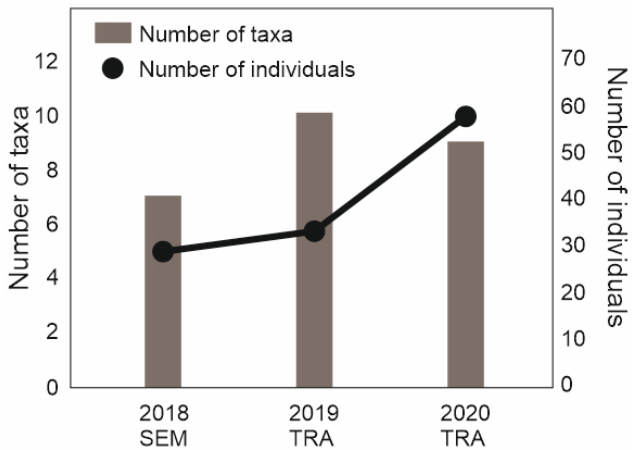
Figure 7. Number of bats species and individuals in given years of the study: 2018—before transformation to waterholes for European bison (SEM); 2019–2020—after transformation (TRA).